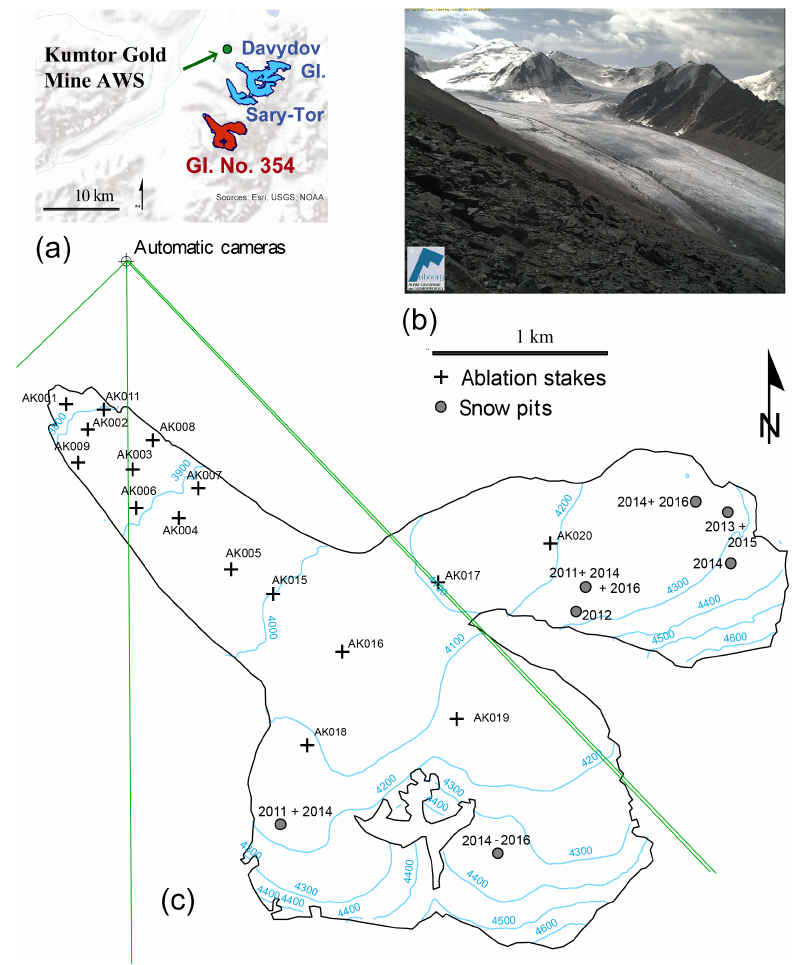
Figure 10. Mass balance network (c) on Glacier No. 354 (Kyrgyzstan) with corresponding (overview) map (a) and snow line camera (b)